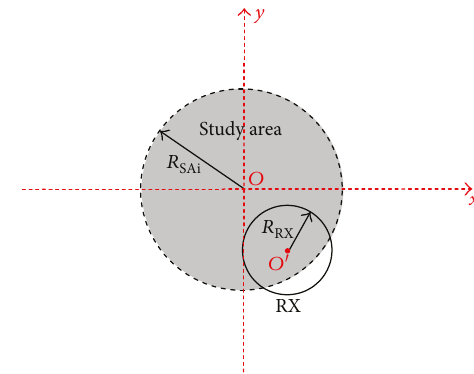
Figure 2: The RX moving within the circle of the study area for optimal PTE